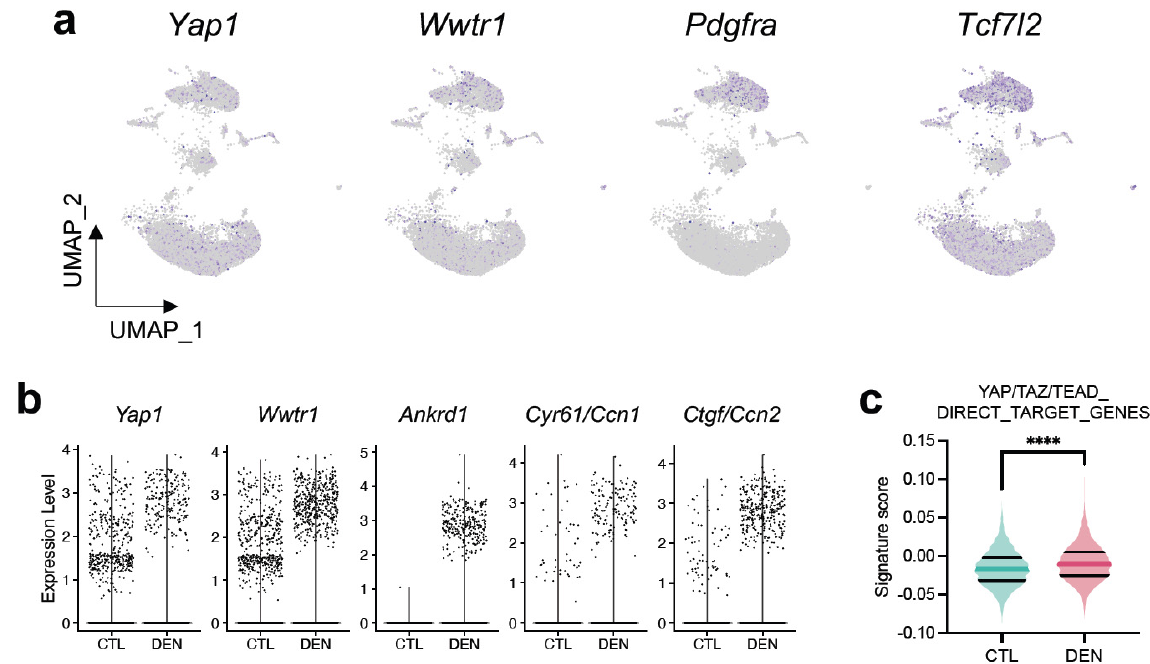
Figure 5. snRNA-seq reveals muscle denervation is coupled with YAP/TAZ activation in FAPs. ( a ) Dimensionality reduction plot (UMAP) showing Yap1 , Wwtr1 , Pdgfra , and Tcf7l2 expressions from control skeletal muscles. ( b ) Violin plot showing Yap1 , Wwtr1 , Ankrd1 , Cyr61/Ccn1 , and Ctgf/Ccn2 expressions in FAPs from DEN (N = 3634 cells) and CTL (N = 3596 cells) GST muscles. ( c ) Signature score of YAP/TAZ/TEAD direct target genes in FAPs as in ( b ). **** = p < 0.0001; unpaired t test.